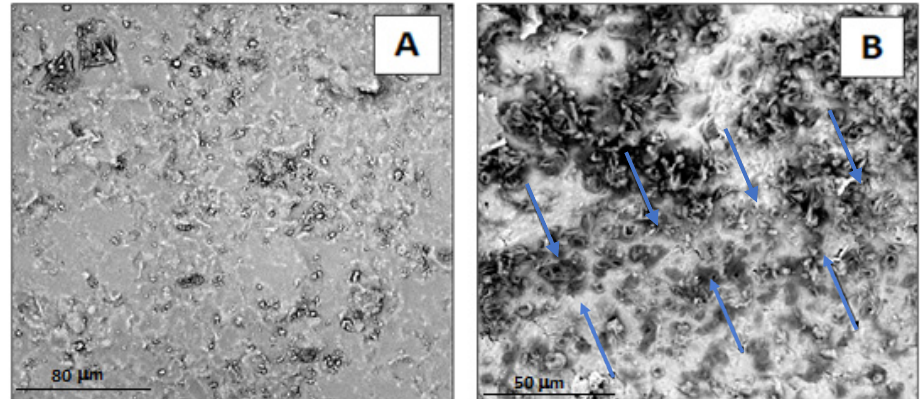
Figure 9. Scanning electron microscope (SEM) micrographs of ( A ) ceramic substrate and ( B ) interfacial transition zone (indicated by the blue arrows) between the ceramic substrate (upper part of the figure) and MK-PVAc-10 geopolymer composite (low part of the figure).